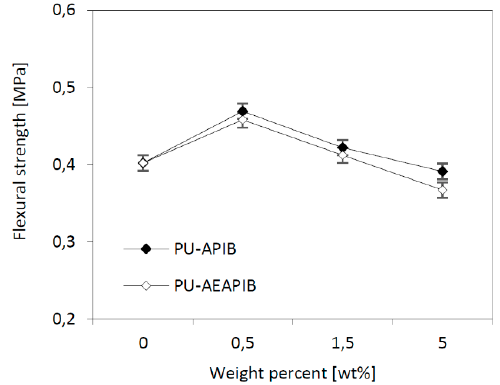
Figure 10. Effect of POSS’s content on flexural strength ( σ f ) of RPUFs .